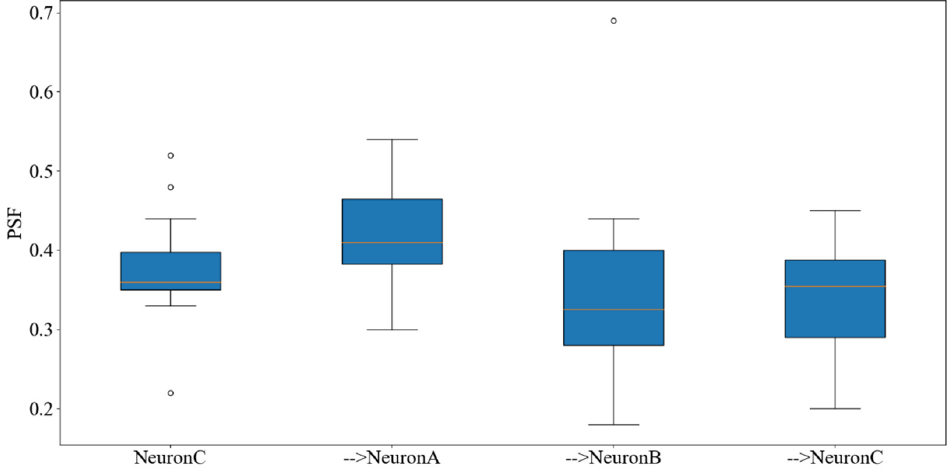
Figure 6. PSF distribution diagram of three neurons model 1(b-2) in different connection States.